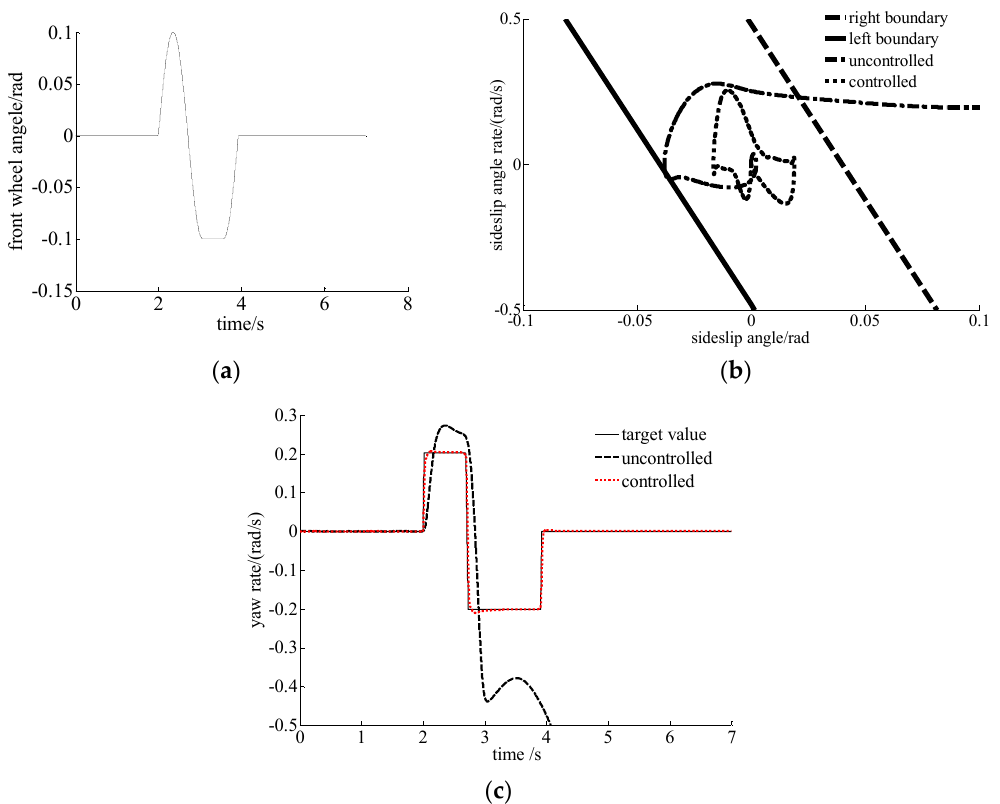
. β phase plane of vehicle, and